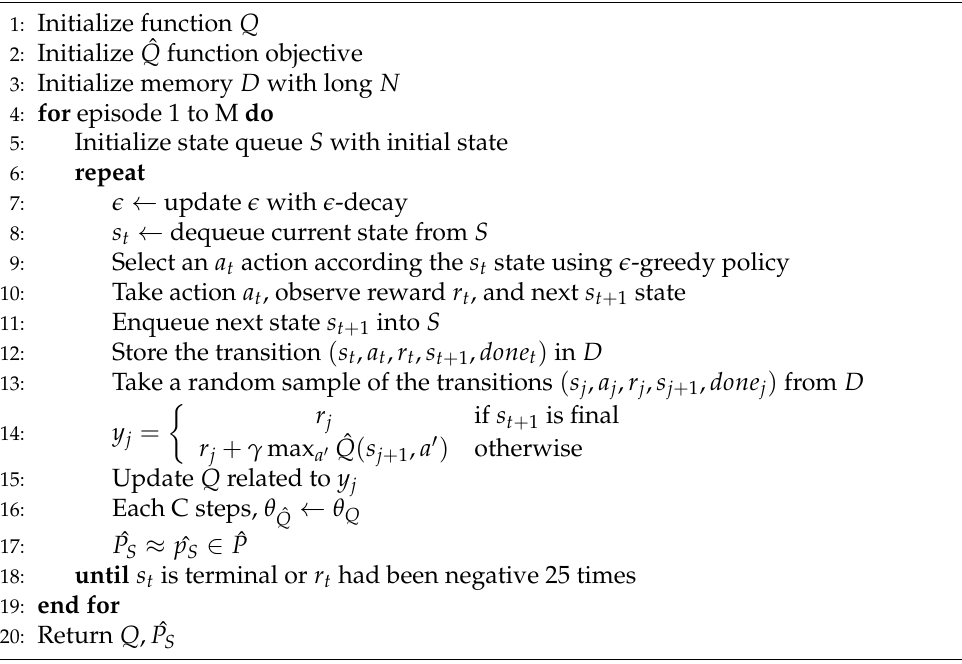
Algorithm 2 Explainable goal-driven reinforcement learning approach for computing the probability of success using the introspection-based method. The algorithm is mainly based on [29] and includes the probabilistic introspection-based